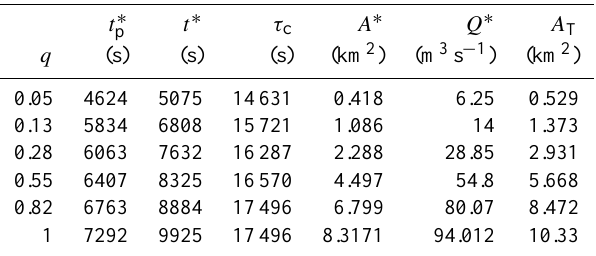
Table 1. Relevant quantities calculated for the rescaled width func- tions of the Longo catchment ( r =10): q is the fraction of saturated areas; t ∗ p is the duration of the rainfall which gives the largest peak discharge; t ∗ the time to peak; τ c the concentration time; A ∗ the area contributing to the peak; Q ∗ is the largest discharge; A T the total saturated